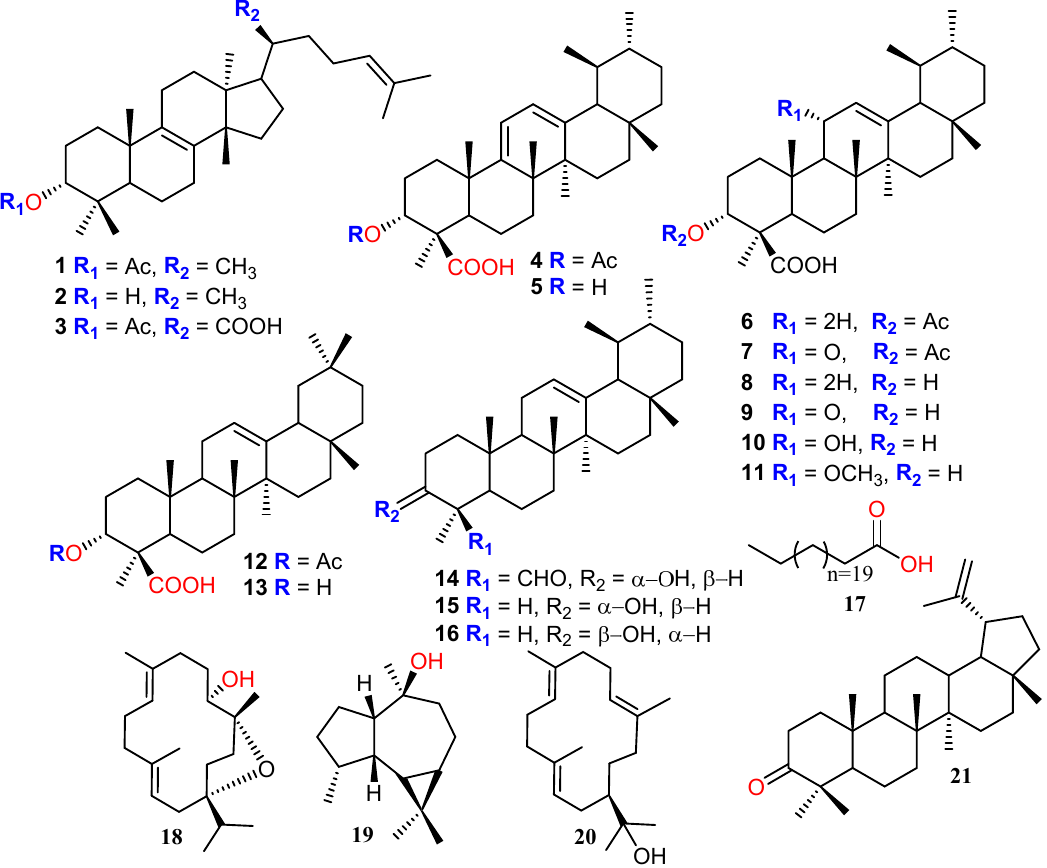
Figure 1. Structures of the compounds 1 – 21 isolated from B. elongata.